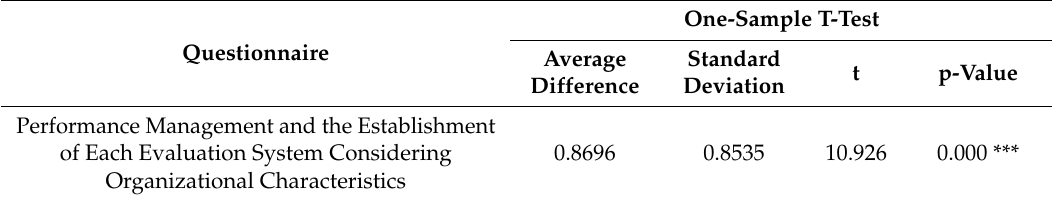
Table 8. Performance management and the establishment of each evaluation system considering organizational